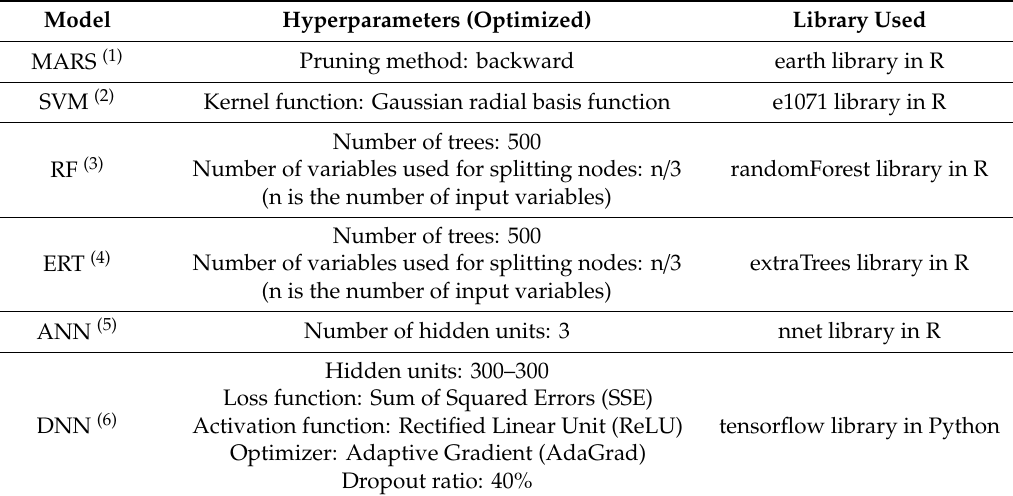
Table 3. Hyperparameters and libraries used for the six AI models in this study.